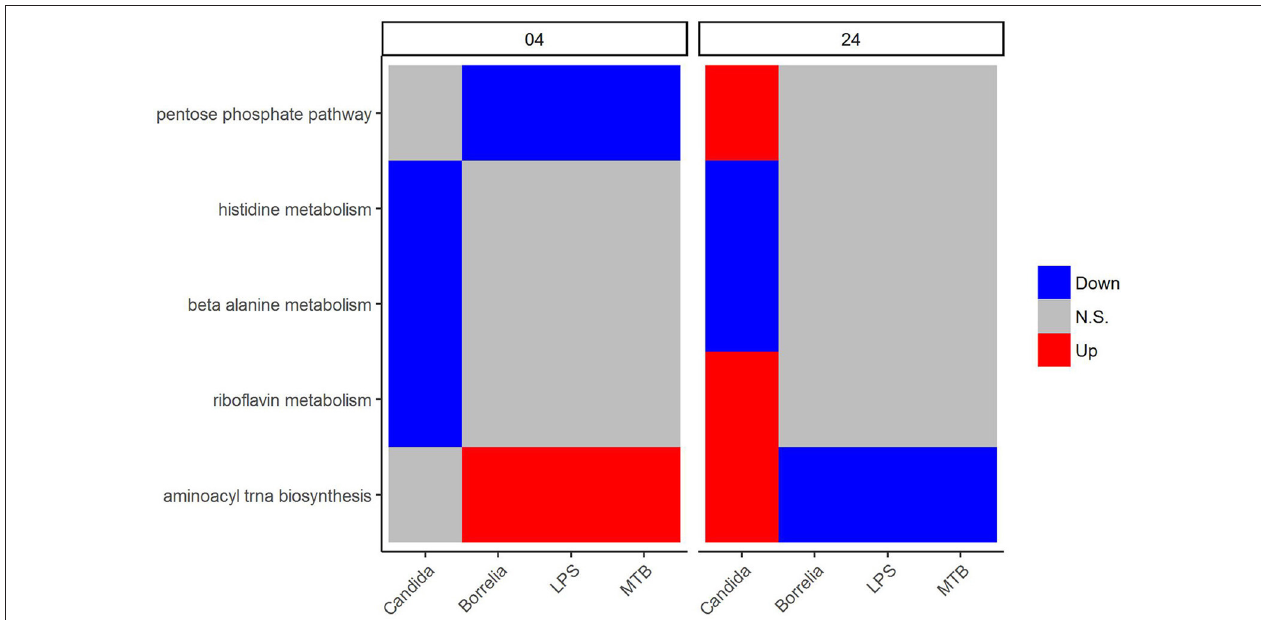
FIGURE 5 | KEGG metabolic pathways that discriminated Candida -stimulated PBMCs from Borrelia , LPS, and MTB-stimulated human PBMCs. Blue refers to significantly down regulation. Red refers to significantly up regulation. Gray means not significantly changed. A pathway is significantly changed if its FDR < 0.05.